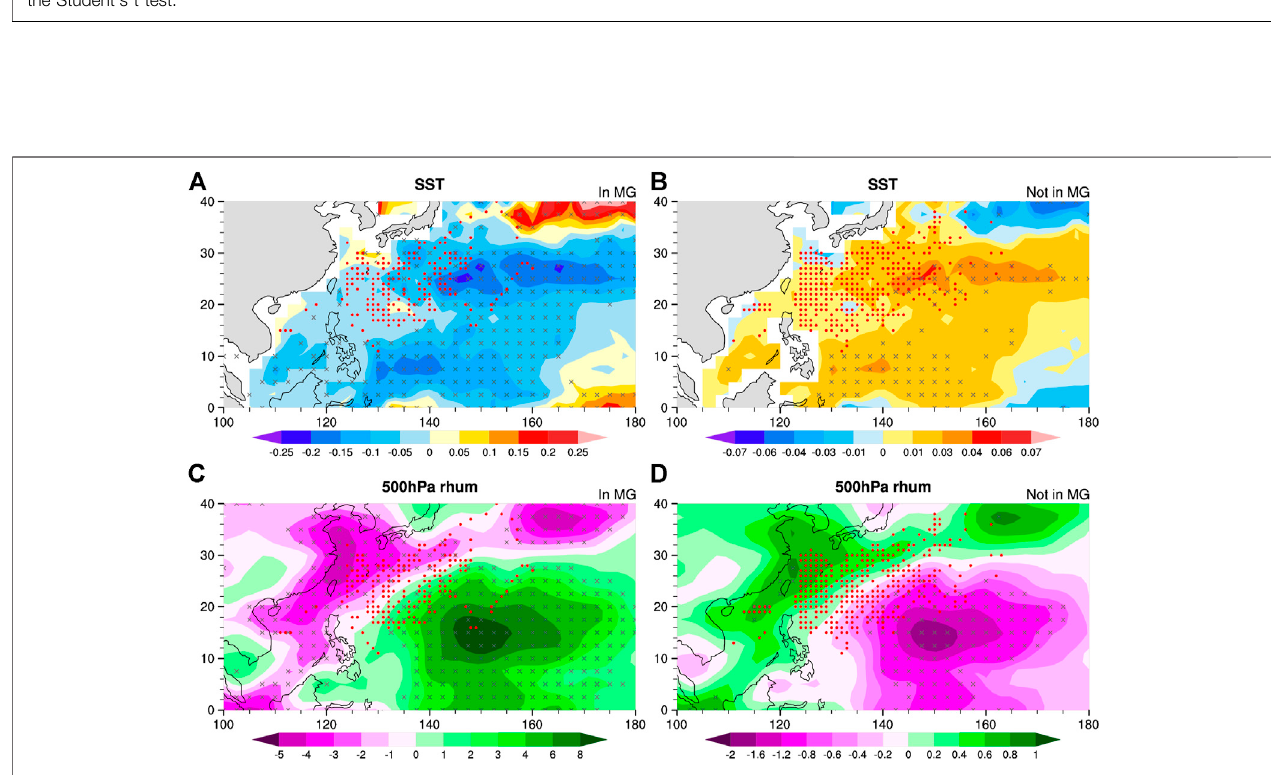
FIGURE 7 | SST anomalies ( ° C, shadings) with the daily climatology removed during the MG period (A) and the non-MG period (B) and mid-level relative humidity anomalies(%,shadings)withthedailyclimatologyremovedduringtheMGperiod (C) andthenon-MGperiod (D) .ThereddotsarethelocationsoftheRWeventsduring the corresponding periods. The black crosses represent the area where the statistical signi fi cance exceeds the 95% con fi dence level based on the Student ’ s t test.